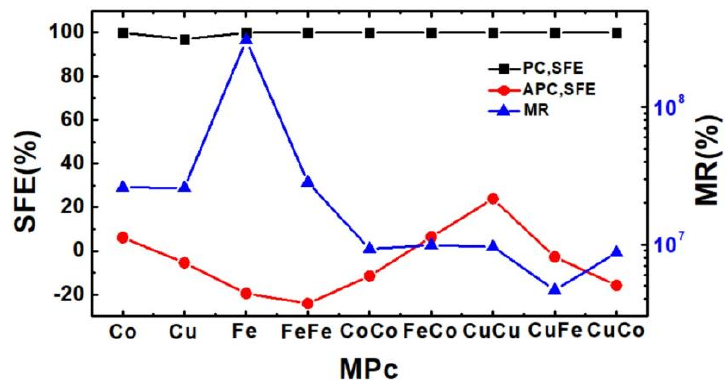
Figure 3. The SFE and MR of the MPc molecular device for the monolayer CoPc, CuPc, FePc, bilayer CuPc-FePc, CuPc-CoPc, CuPc-CuPc, FePc-FePc, CoPc-CoPc, and FePc-CoPc at zero bias. CuPc-FePc, CuPc-CoPc, CuPc-CuPc, FePc-FePc, CoPc-CoPc, and FePc-CoPc at zero